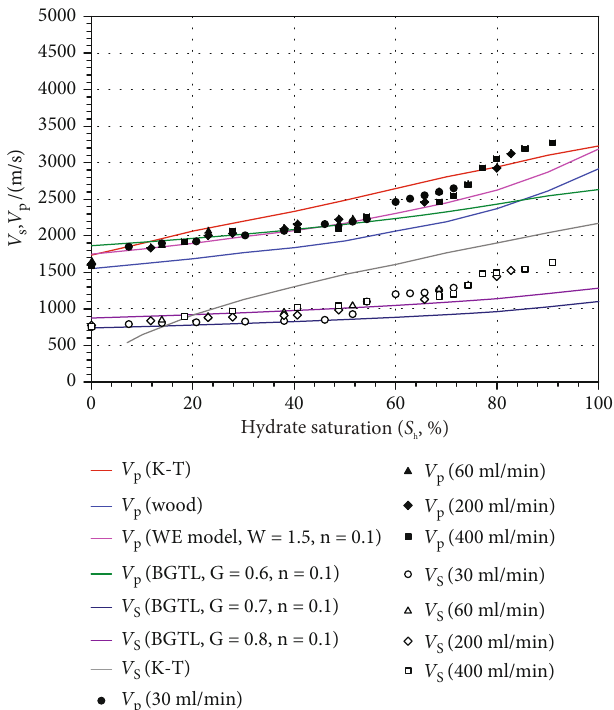
and V with hydrate saturation (Data for Figure 8 are in Table S8 in the p s